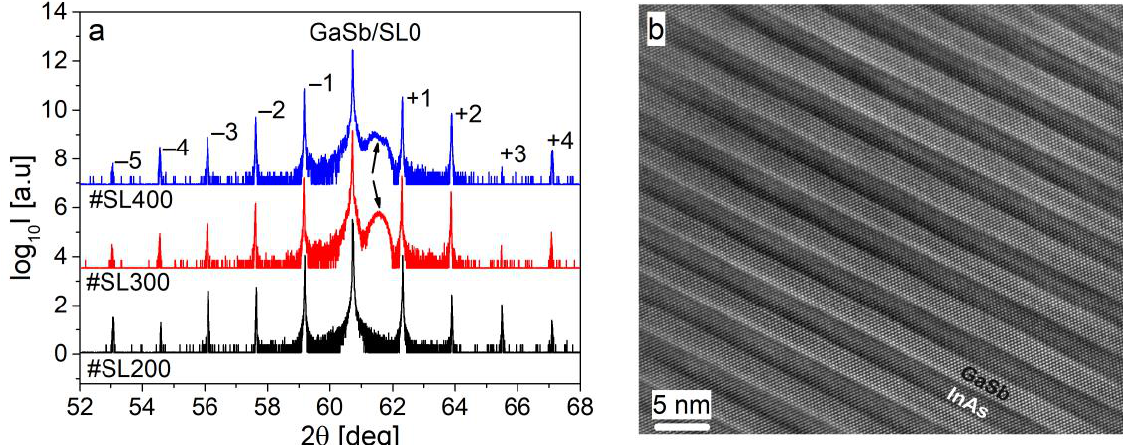
Figure 1. ( a ) Measured 2 θ / ω curves for superlattices #SL400, #SL300, and #SL200. Peaks from thin InAs cap layers present in #SL300 and #SL400 are marked by arrows. ( b ) HRTEM image of #SL200 superlattice—the successive InAs and GaSb layers are visible.